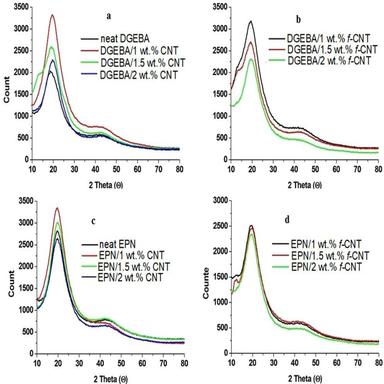
XRD patterns of: a) DGEBA/CNT composites; b) DGEBA/f-CNT composites; c) EPN/CNT composites; d) EPN/f-CNT composites (at 1.0, 1.5 and 2.0 wt% of fillers).